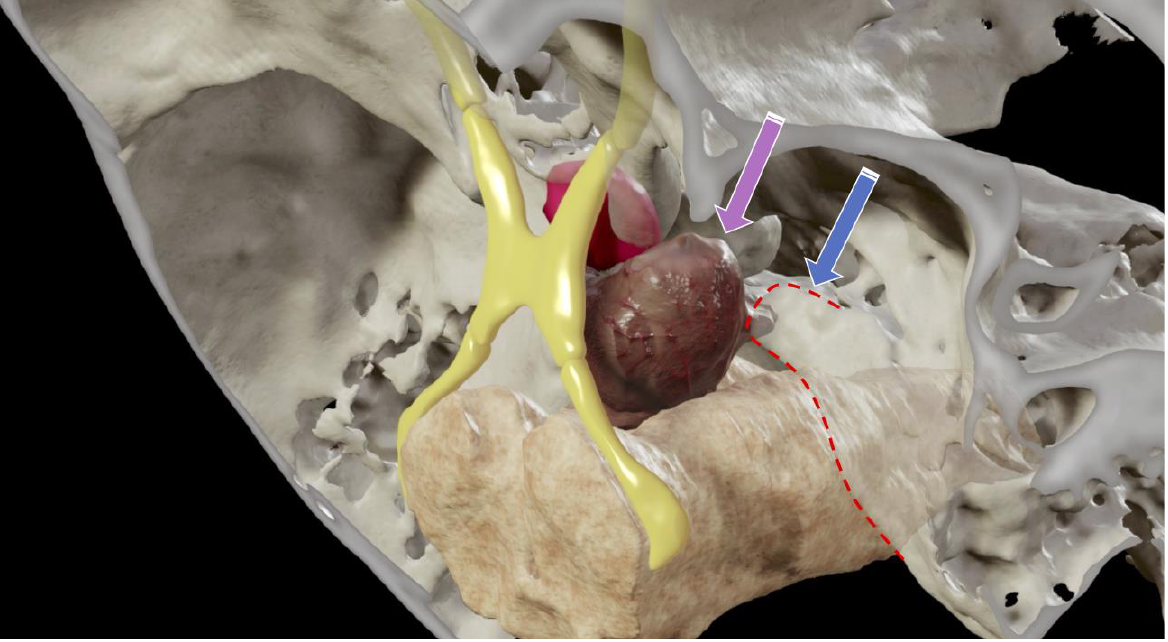
Figure 3. Three-dimensional reconstruction showing the potential surgical corridor provided by an anterior petrosal approach (blue arrow) versus the transcavernous approach (pink arrow). Optic apparatus (yellow), petrous apex and ridge limit (dotted red line), pituitary gland (magenta), tumor (maroon).